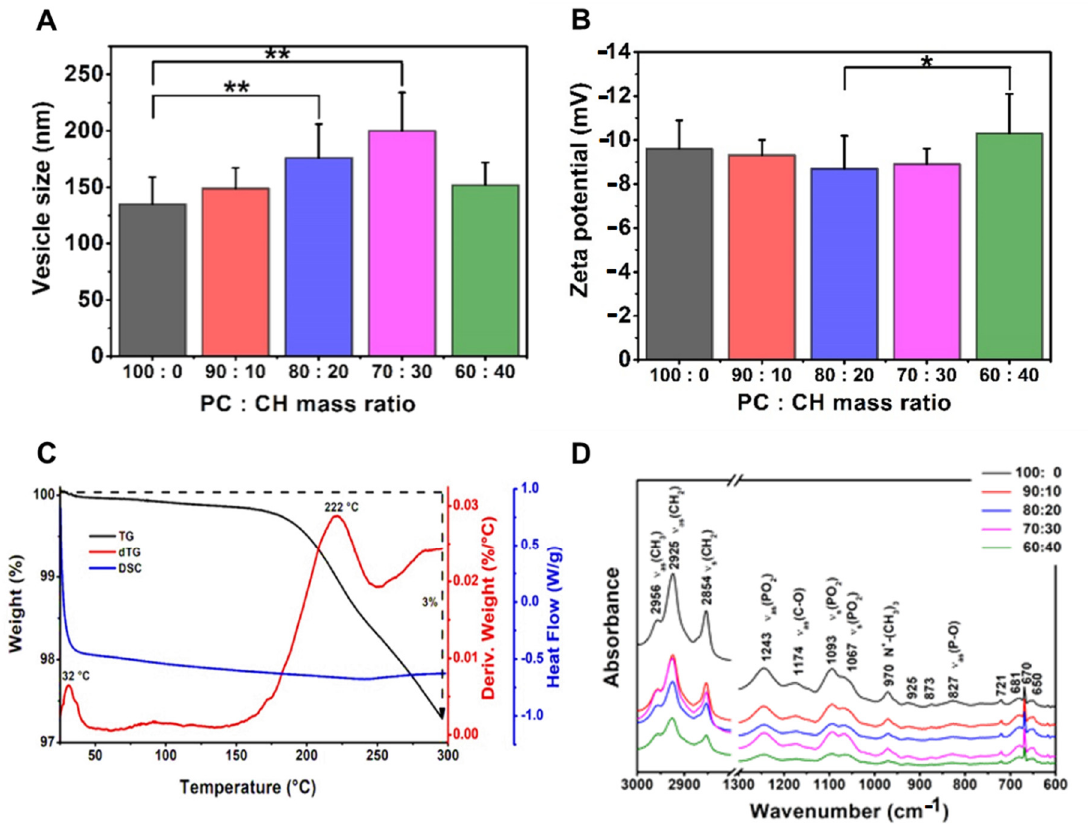
Figure 5. Characteristic features of the liposome samples prepared from different ratios of phosphatidylcholine (PC) and cholesterol (CH) at 60 °C, and hydrated with saline solution, presenting the results of the investigations: vesicle size and zeta potential analysis ( A , B ), differential scanning calorimetry and thermogravimetric analysis ( C ) and Fourier-transform infrared spectroscopy ( D ). *: p <0.05; **: p < 0.01. Table 8. Measurement results of the liposome samples prepared from different phosphatidylcholine (PC) and cholesterol (CH) ratios at 60 °C and hydrated with saline solution.